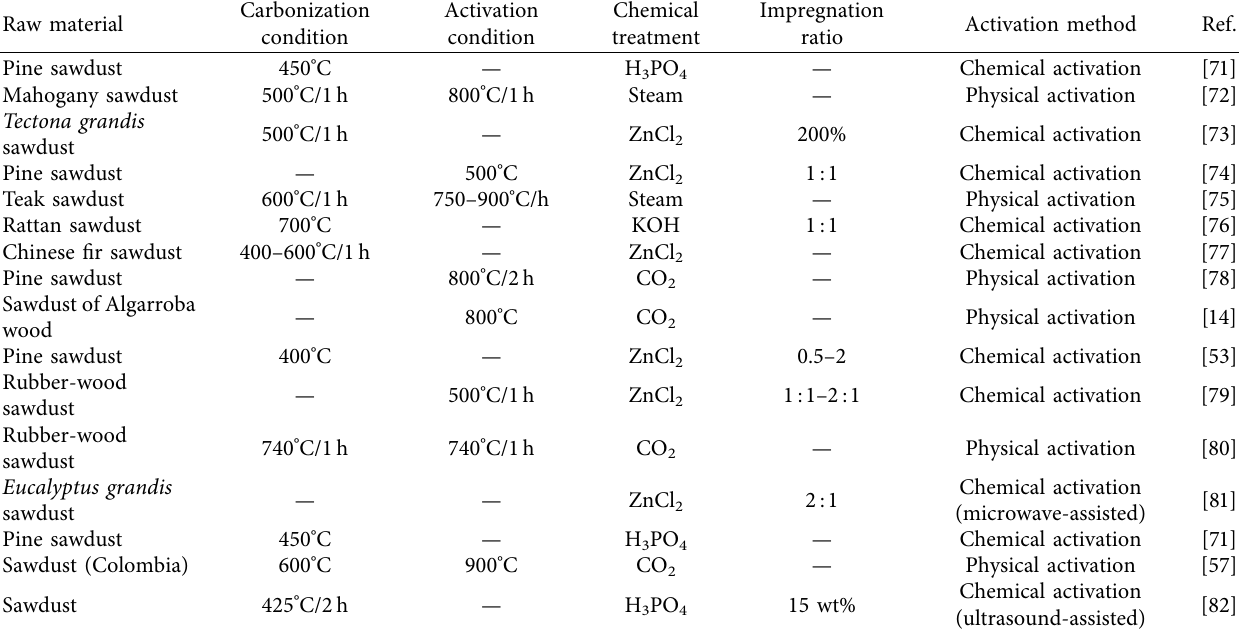
Figure 3: Diagram for activation process of sawdust-derived activated carbon. Table 5: Carbonization and activation condition of various